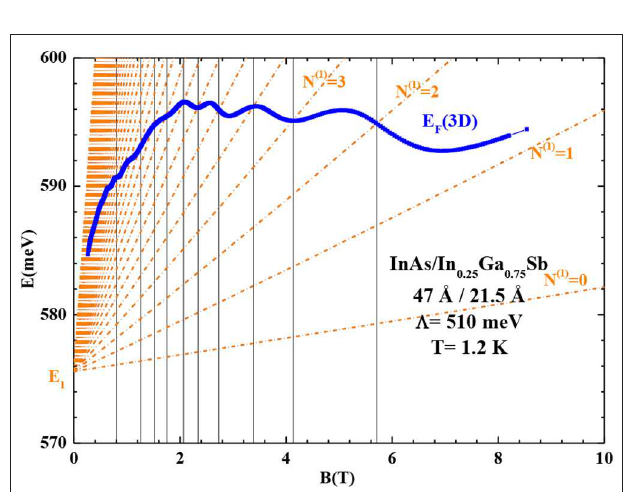
FIGURE 9 | Calculated Landau levels of E 1 as a function of the applied magnetic field in the investigated SL at 1.2 K. E F is the Fermi level